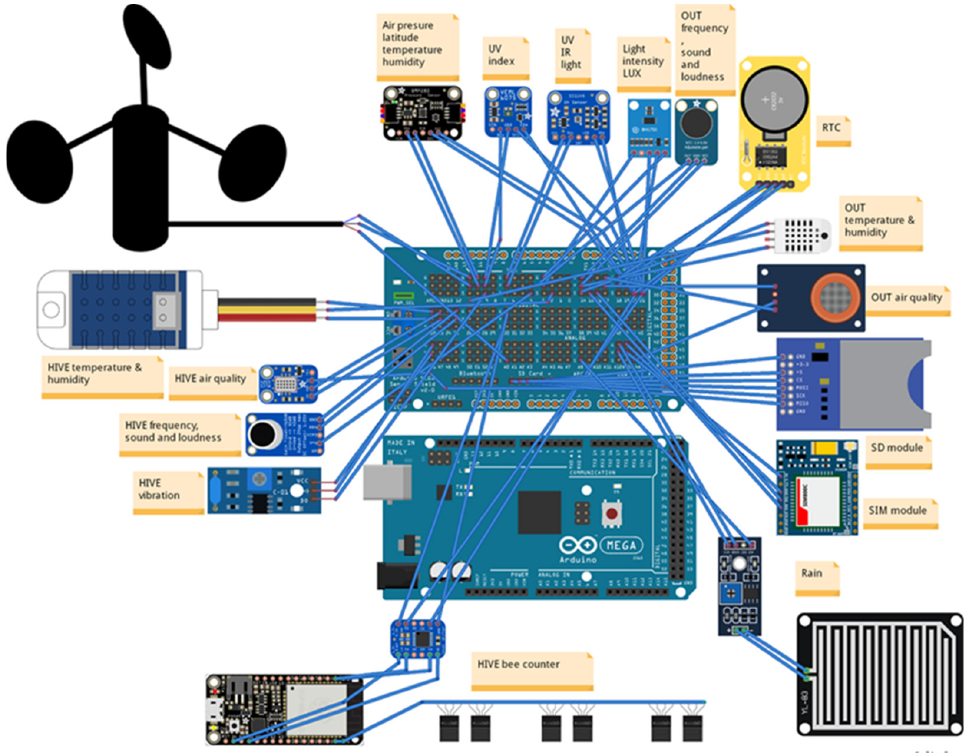
Figure 4. System schematic (created in Fritzing [67]).